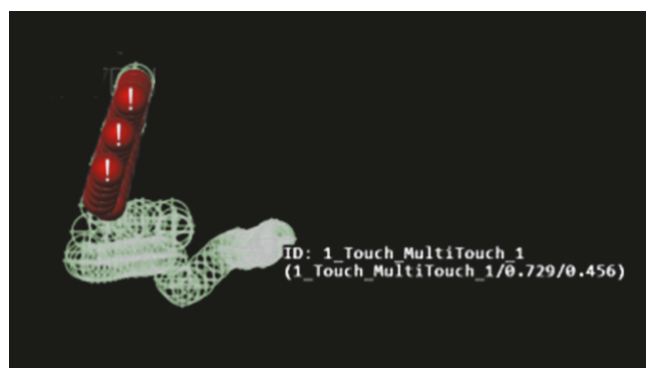
Figure 8: The computer screenshot of one-hand gesture tracking based on Cam-shift algorithm.